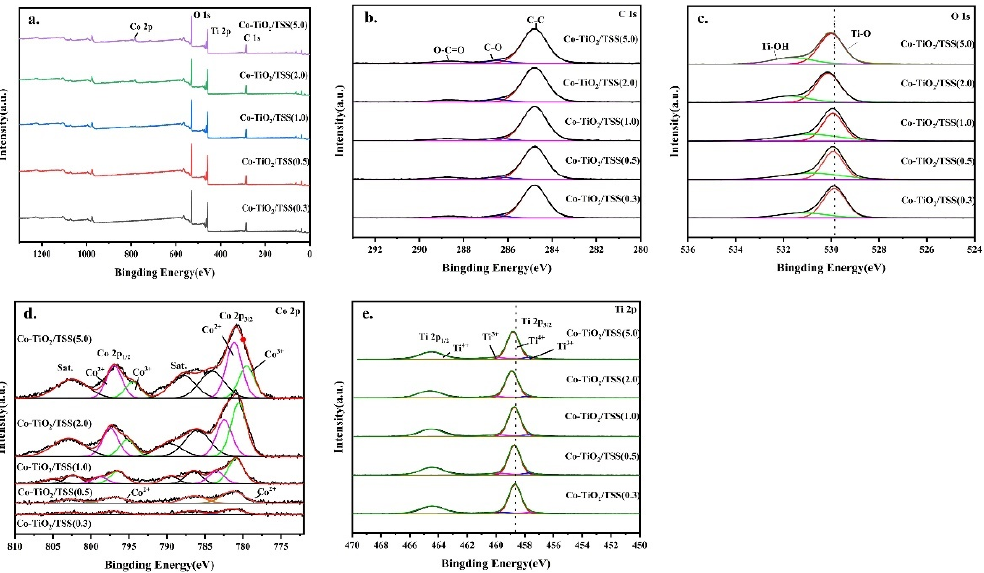
Figure 7. XPS spectra of (a) survey spectra, high-resolution XPS spectra of (b) C 1s, (c) O 1s, (d) Co 2p and (e) Ti 2p for as-prepared samples.